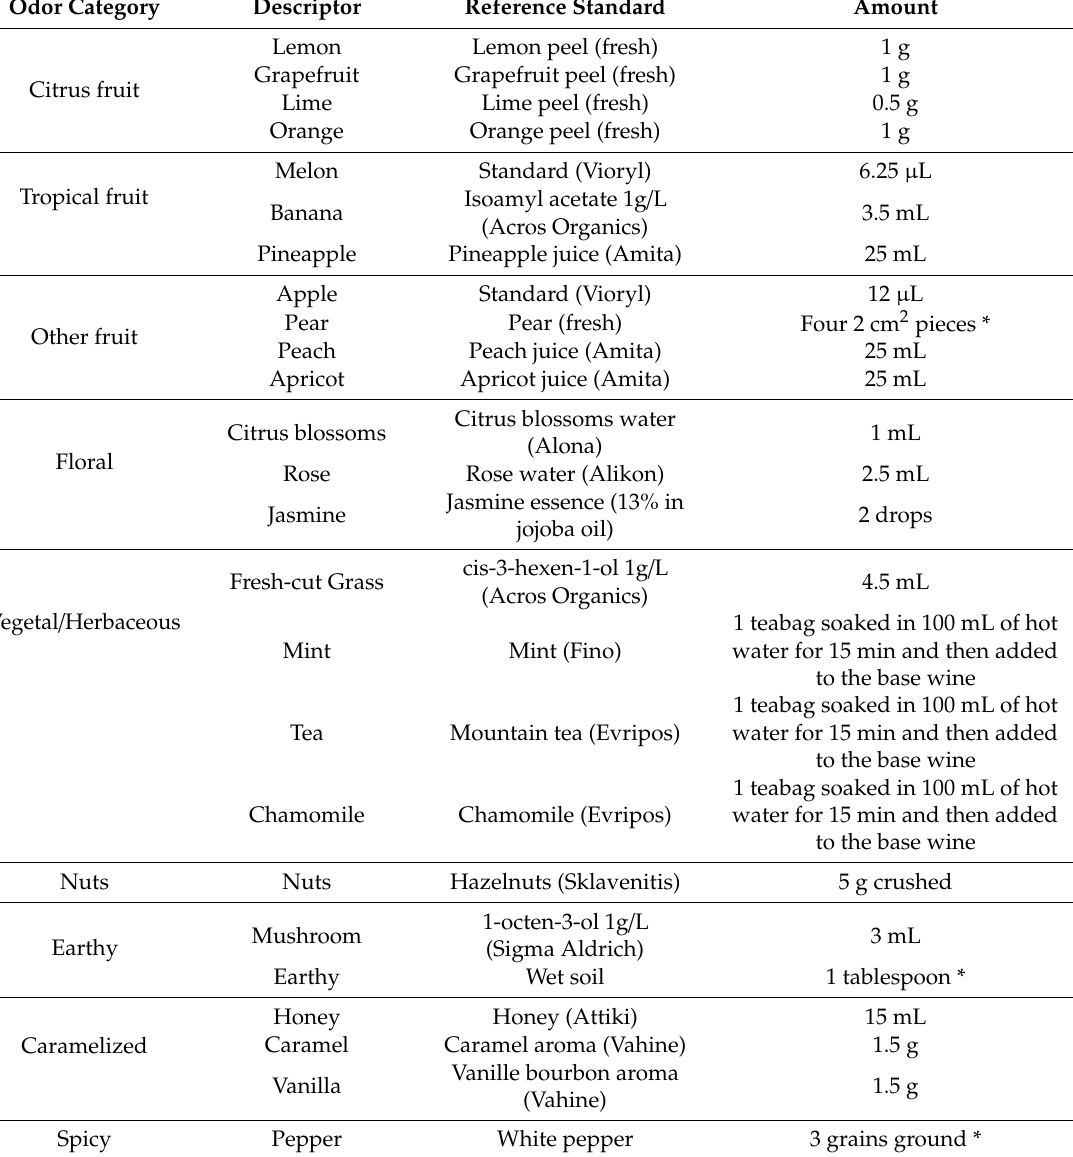
Table 2. Reference standards used during training. The amounts shown were added to 100 mL of white base wine unless otherwise